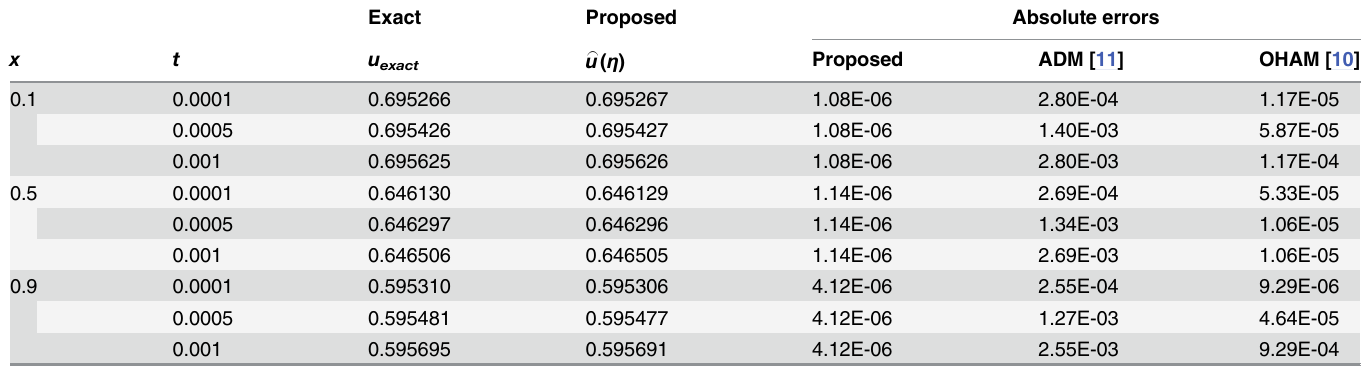
Table 7. Comparison of numerical solutions and absolute errors between the proposed scheme, OHAM [10] and ADM [11] for α = β = 1 and δ = 2. Exact